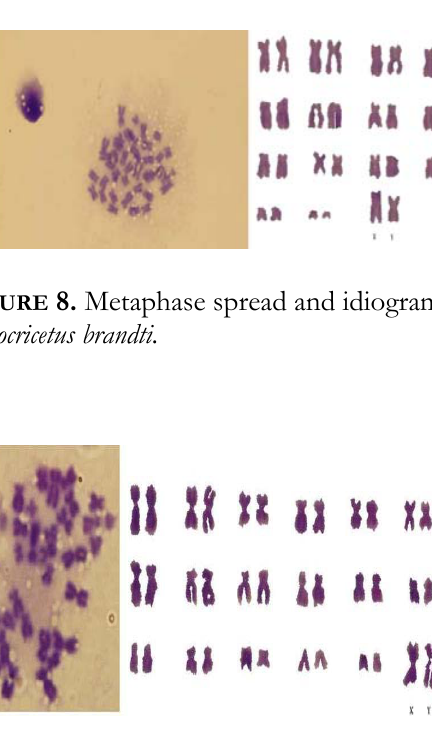
F IGURE 11. Metaphase spread and idiogram of Funambulus pennantii .